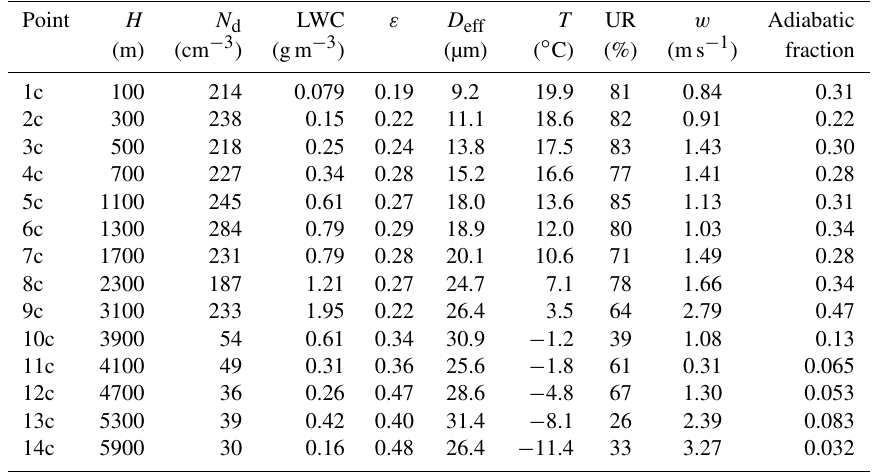
Table 2. Properties of the points highlighted in Fig. 8 for flight RA1. H is shown as the average of each of the 200m vertical bins. The adiabatic fraction is defined as the ratio between the observed and adiabatic LWC.